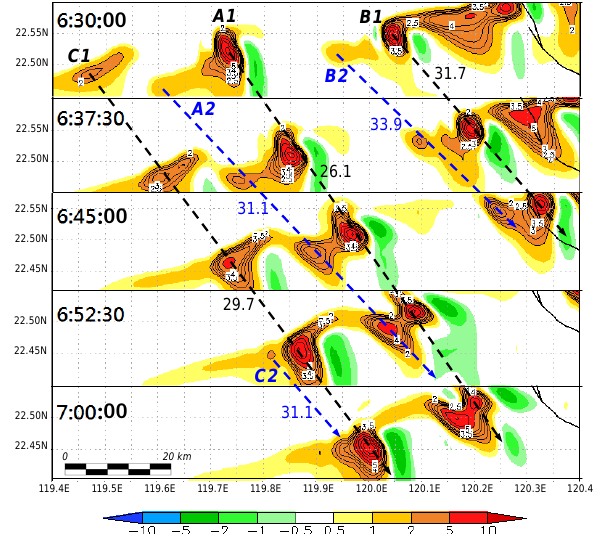
Figure 8. Similar to Fig. 4, but showing model-simulated vertical velocity (ms − 1 , color shades and contours) at the height of 1058m (sixth output level) over the period of 06:30–07:00UTC (every 7.5min) 8 August 2009 from the 1km experiment. Contours start from 2ms − 1 , at intervals of 0.5 (1.0)ms − 1 up to (above) 4ms − 1 . Old cells (A1, B1, and C1) and nearby new cells (A2, B2, and C2) and their estimated propagation speeds (ms − 1 ) are